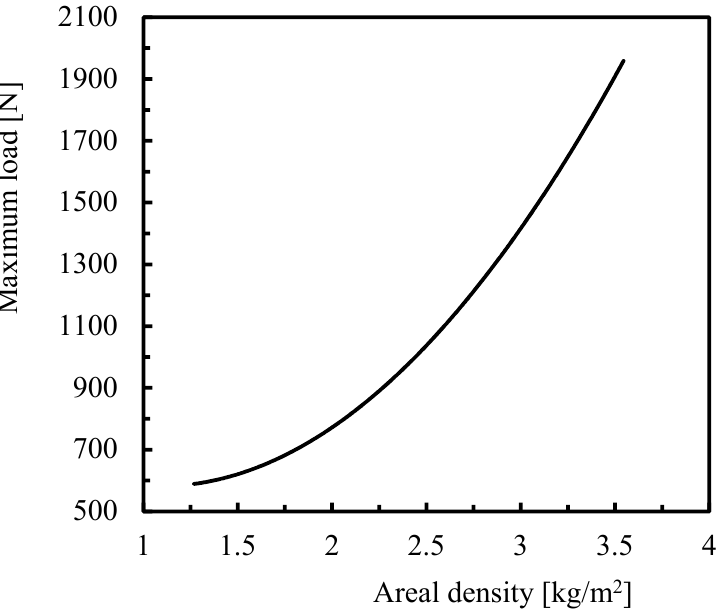
Figure 9. Maximum load versus areal density.